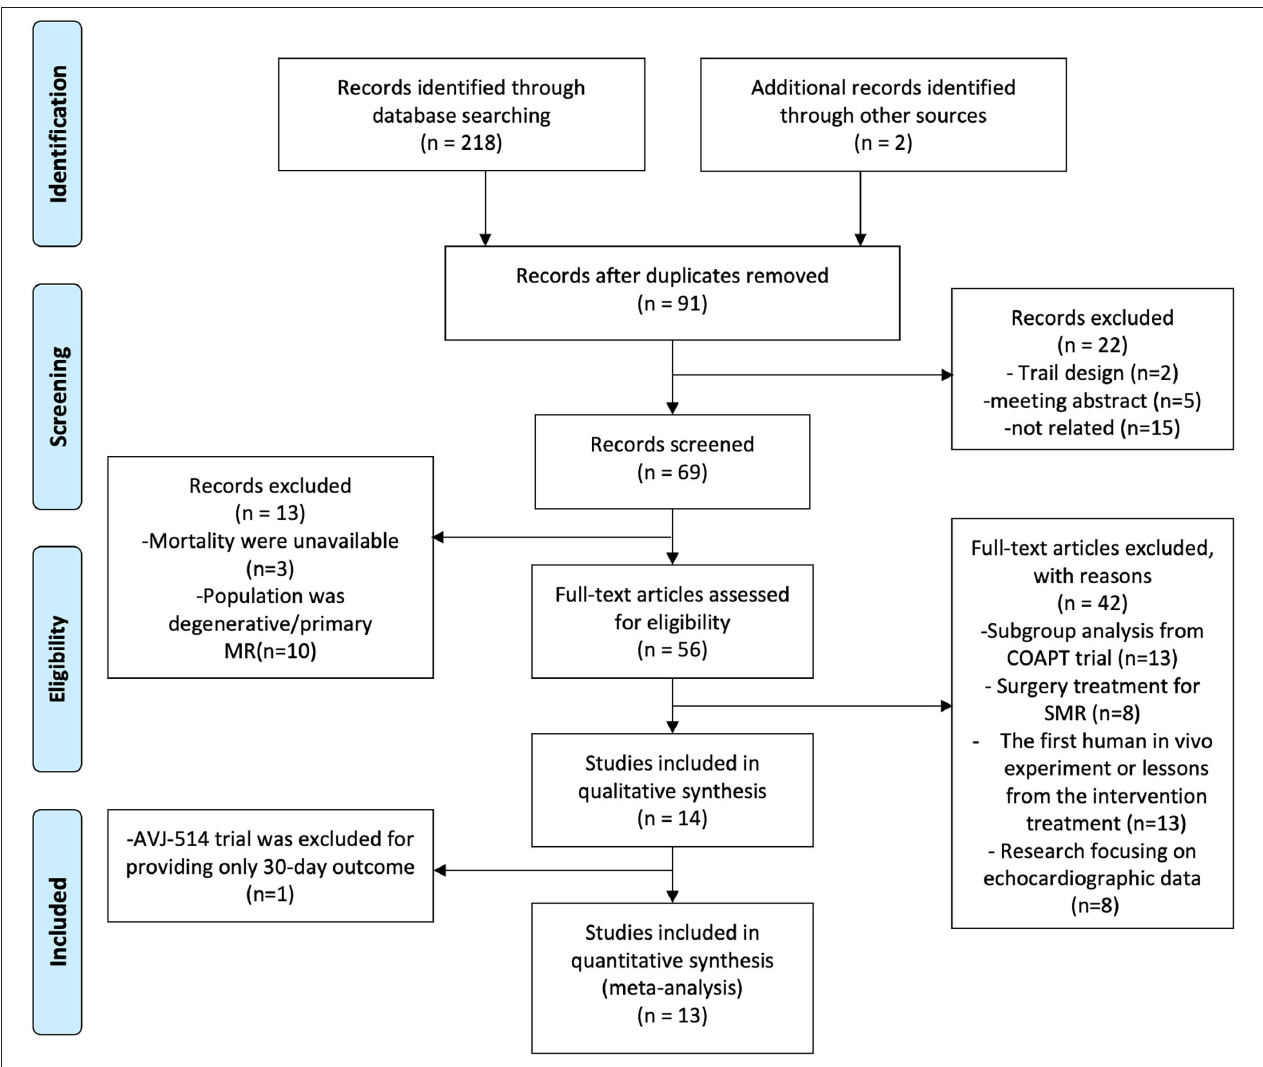
FIGURE 1 | Flowchart of included